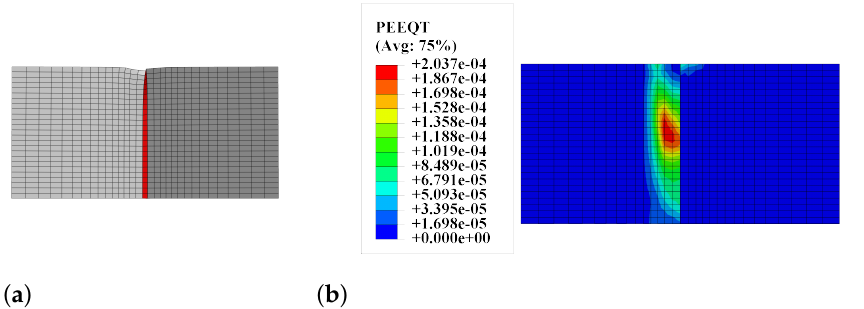
Figure 16. ( a ) The splitting test—deformed mesh. ( b ) The splitting test—a map of the equivalent plastic strain in tension PEEQT.